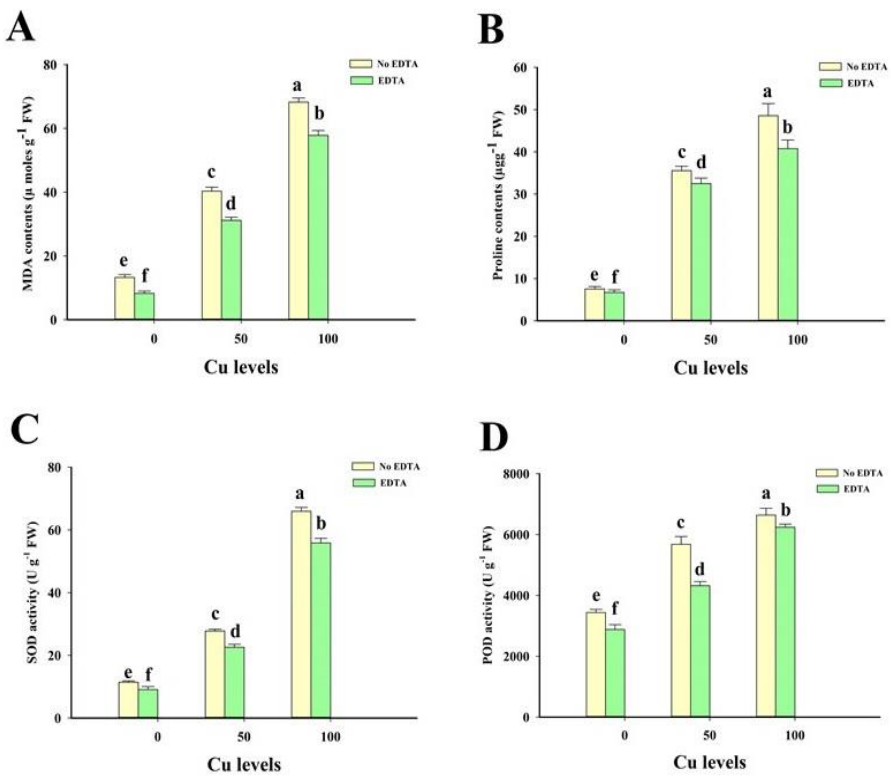
Figure 2. Effect of different concentrations of Cu with or without the application of EDTA on malondialdehyde contents ( A ), proline contents ( B ), superoxidase activity ( C ) and peroxidase activity ( D ) in the roots of C. capsularis seedlings grown in solution medium with increasing Cu concentrations (0, 50 and 100 μM) treated with and without 3-mM EDTA. The given values are means ± SD (n = 3). One-way ANOVA was performed and means differences were tested by highest significant difference HSD ( P < 0.05). Different lowercase letters in figure indicate significant difference between the treatments.